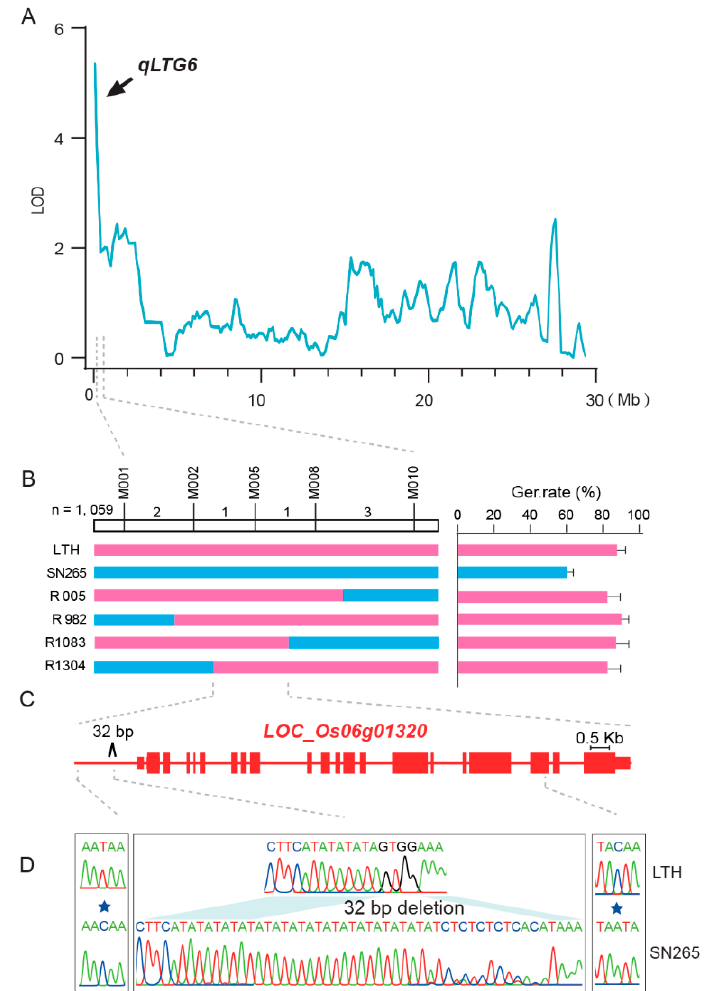
Figure 4. Identification of the candidate gene of the QTL, qLTG6 . ( A ). Linkage analyses of the QTL, qLTG6 ; ( B ). Graphical representation of recombinants in the RILs of germinability under low temperatures, refining the location of qLTG6 in an interval defined by bin markers; ( C ). The identification of the candidate gene, LOC_Os06g01320 , which encodes a chromodomain, helicase / ATPase, and DNA-binding domain (CHD)-related (CHR) proteins, CHR723; ( D ). Validation of the mutation of LOC_Os06g01320 by PCR sequencing.